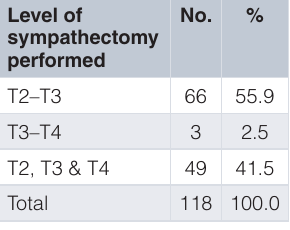
Table 2. Level of sympathectomy performed.